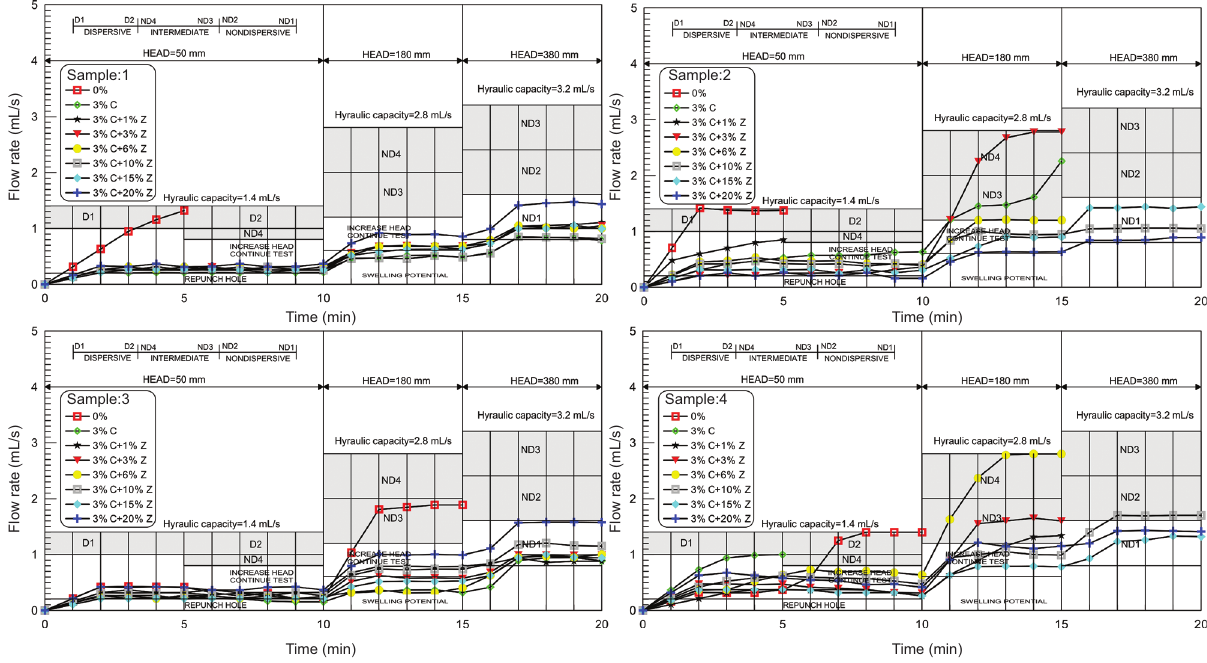
Figure 9 Pinhole test results of the soil samples mixed with different additive contents.